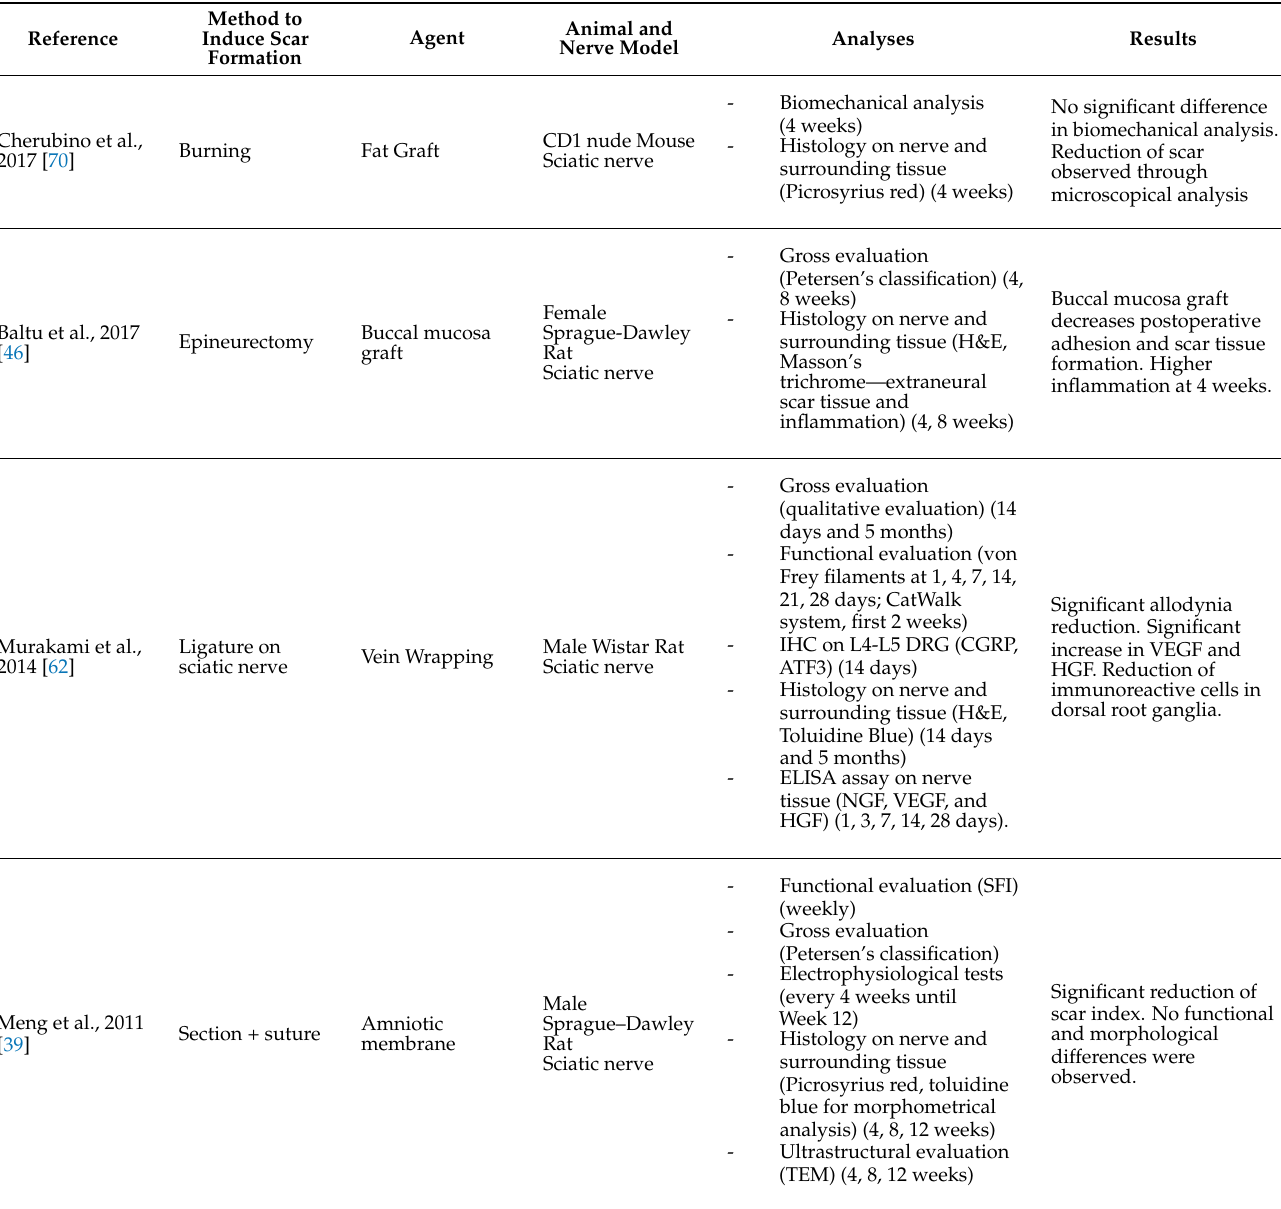
Table 4. Autologous tissues used as antiscarring